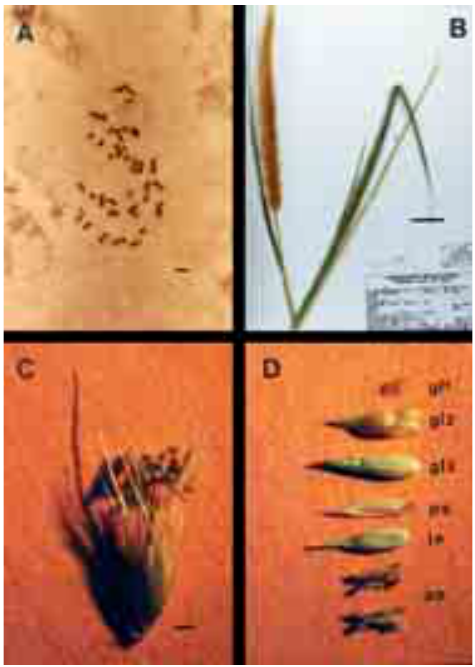
Figure 5 - Wild BAG 12 ( P. nervosum ). A. Mitotic metaphase with 2n = 36 chromosomes; B. Specimens; C. Spikelet; D. Constituent of the spikelet: an (anthers), le (lemma), pa (palea), gl3 (3 rd glume), gl2 (2 nd glume), gl1 (1 st glume). The arrows indicate satellites and the bars repre- sent: A. 5 µ m; B. 5.6 cm; C and D. 2.3 mm. UFLA. Lavras, MG, Brazil,